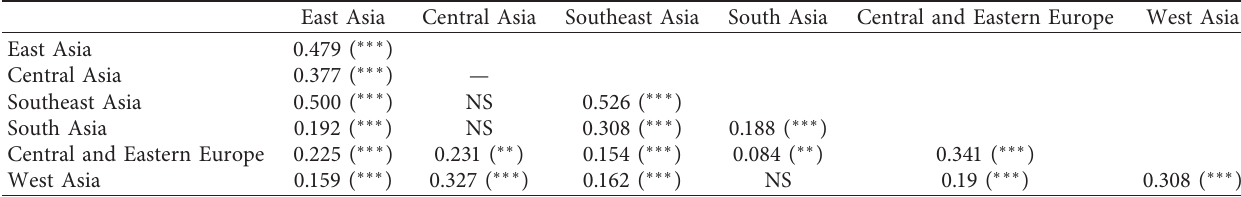
Table 11: Results of OLS regression analysis of population size within and between subregions.